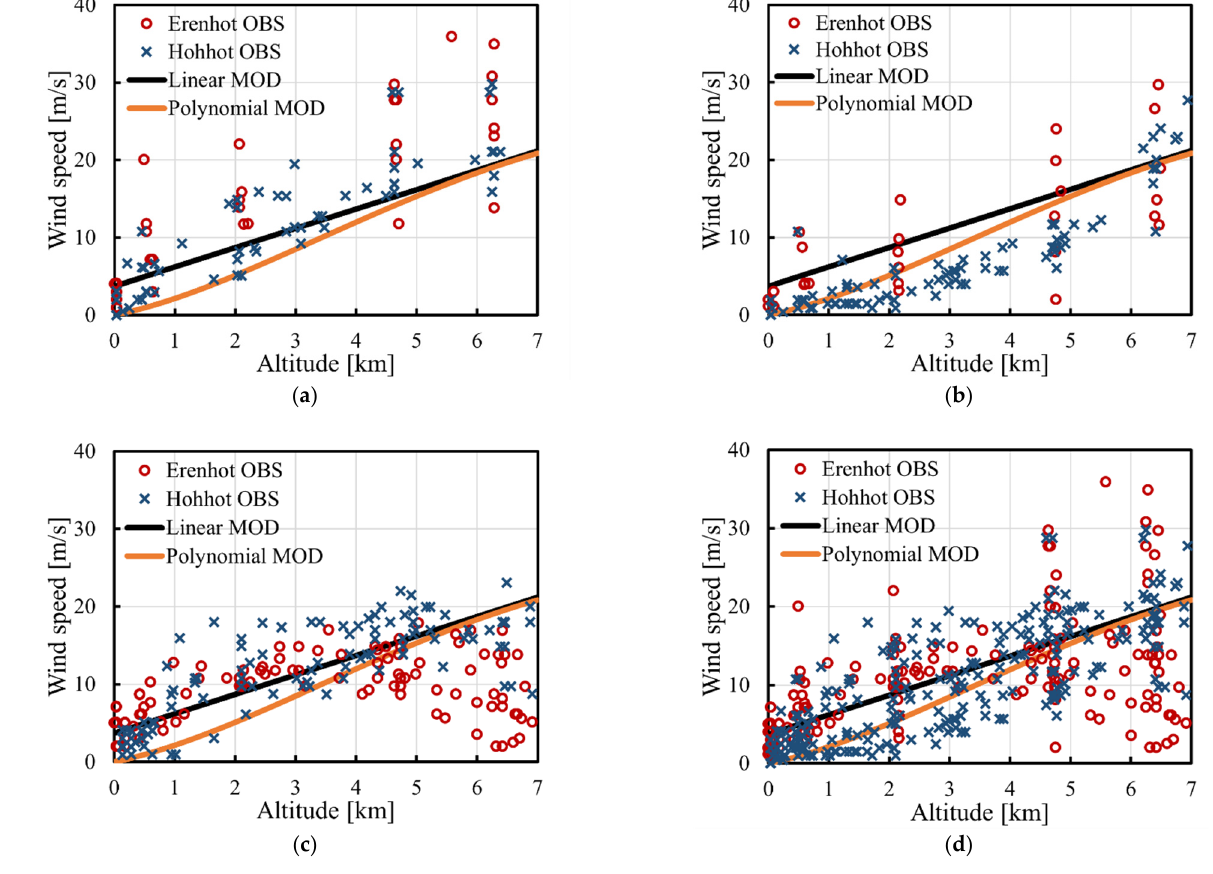
Figure 17. Comparison of modeled and observed wind fields above the main landing area in the ( a ) “Shen Zhou 6” case, ( b ) “Shen Zhou 7” case, ( c ) “Shen Zhou 10” case, and ( d ) the whole case, including the above three cases.